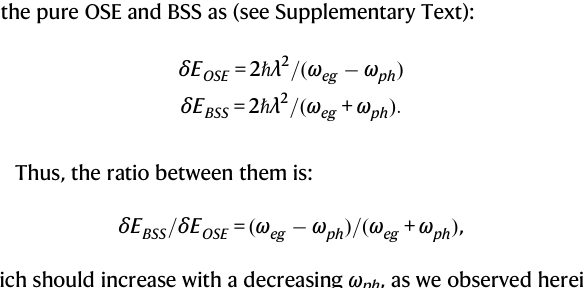
spectra of the CsPbI 3 QDs with ℏ ω ph of 1.74 eV (714 nm; 0.30 GW/cm 2 ), 1.21 eV (1027 nm; 1.71GW/cm 2 ) and 0.805eV (1540nm; 1.86 GW/cm 2 ),